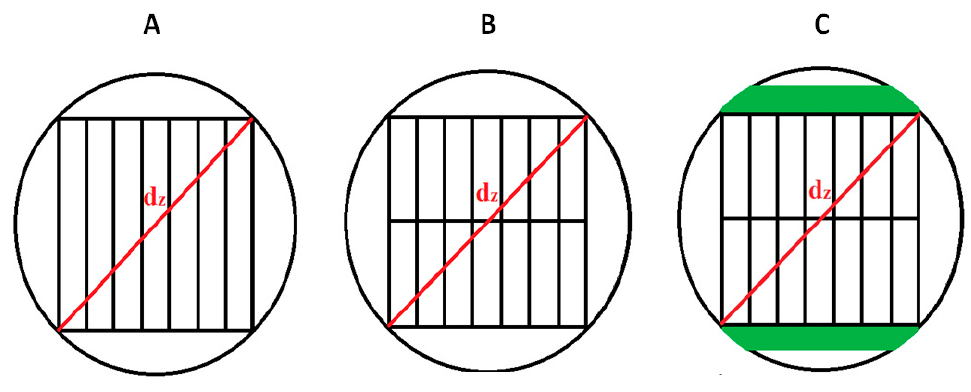
Figure 1. Cant sawing patterns of the milling. Table 1. Nominal dimensions and quantities ( n ) of sawn green lumber and the resulting planed lamellas (dry-dressed